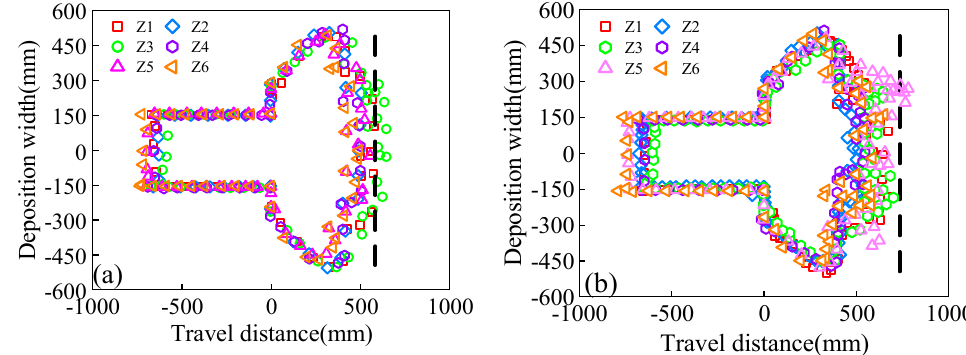
Figure 17. The effect of baffle type on the morphology of the debris flow baffle: ( a ) 50 mm opening distance between baffles, ( b ) 90 mm opening distance between baffles.